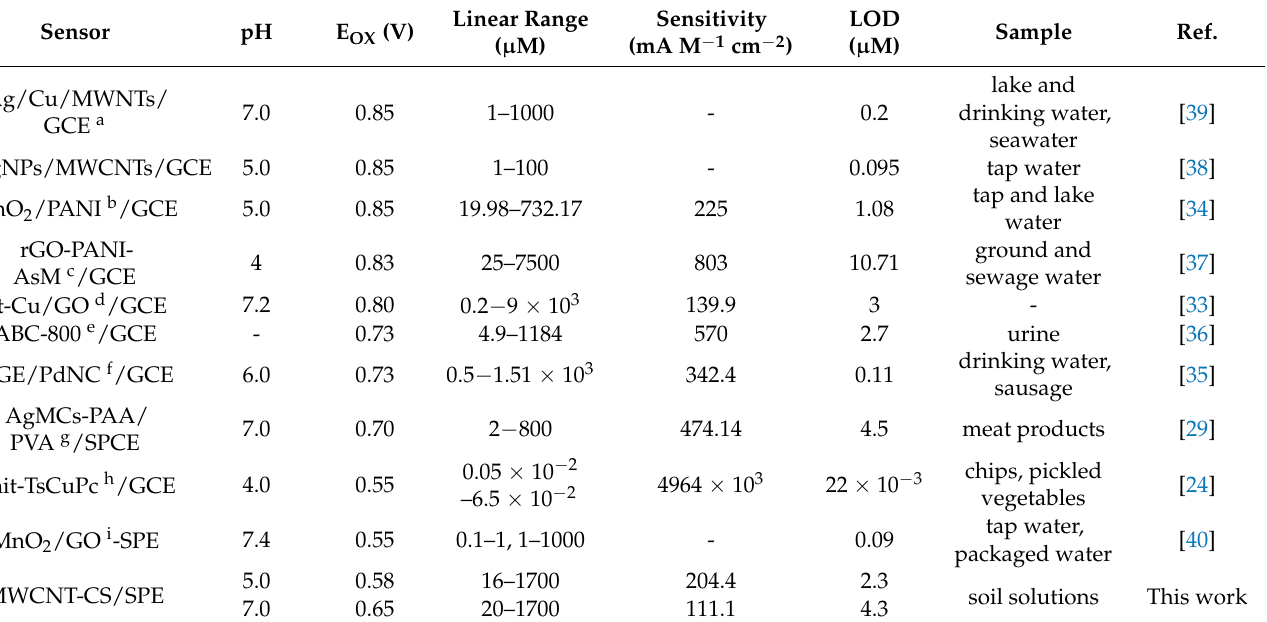
Table 1. Comparison of the MWCNT-CS/SPE sensor with other amperometric sensors reported in the